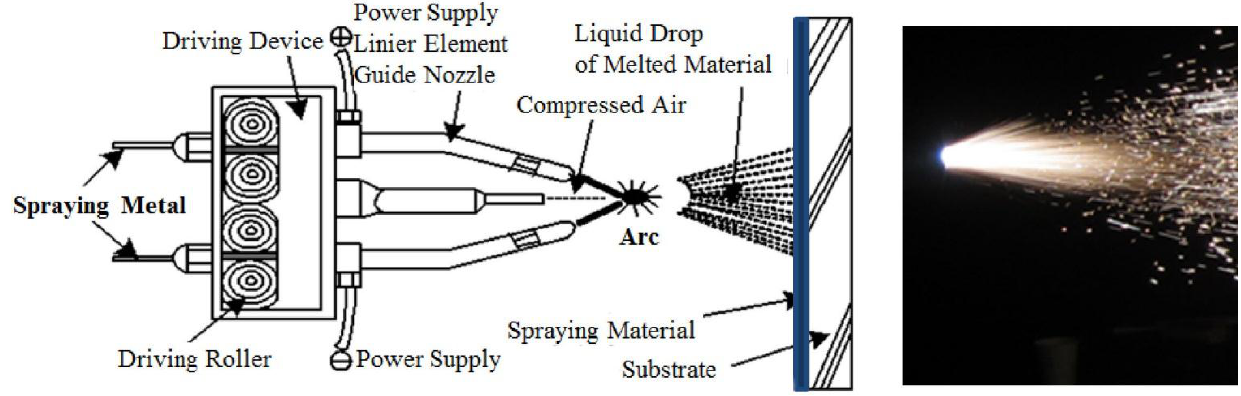
Figure 1. Arc thermal metal spraying